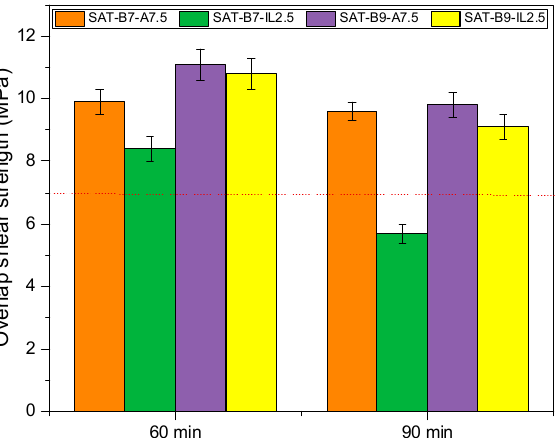
Figure 10. Overlap shear strength of Al/SAT/Al joints after thermal curing at 195 °C for 60 or 90 min. Increase in the curing temperature to 195 °C (while maintaining the same curing time) resulted in an increase in τ values for adhesive joints with the amine hardener (from 5.2 to 9.9 MPa for SAT-B7-A and from 9.9 to 11.1 MPa for SAT-B9-A). In the case of the ionic liquid hardener, only a slight increase (from 10.3 to 10.8 MPa for SAT-B9-IL) or de- crease in τ values (from 9.0 to 8.4 MPa for the SAT B7-IL) was recorded. In turn, the ex- tension of the hardening time at 195 °C to 90 min resulted in a decrease in τ values of adhesive joints (in each case). It is known that the shear of structural adhesives depends on their cross-linking degree, and an optimal range of the latter parameter can be often observed. The cross-linking degree ( α ) and DSC analyses of thermally cured SATs are presented in Figure 11 and Table 5. Figure 11. DSC thermograms of UV-cross-linked SATs.